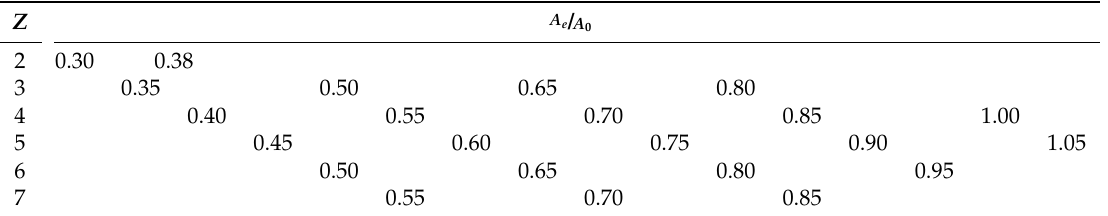
Table 1. Summary of the propeller models of the Wageningen B-screw Series. A e / A